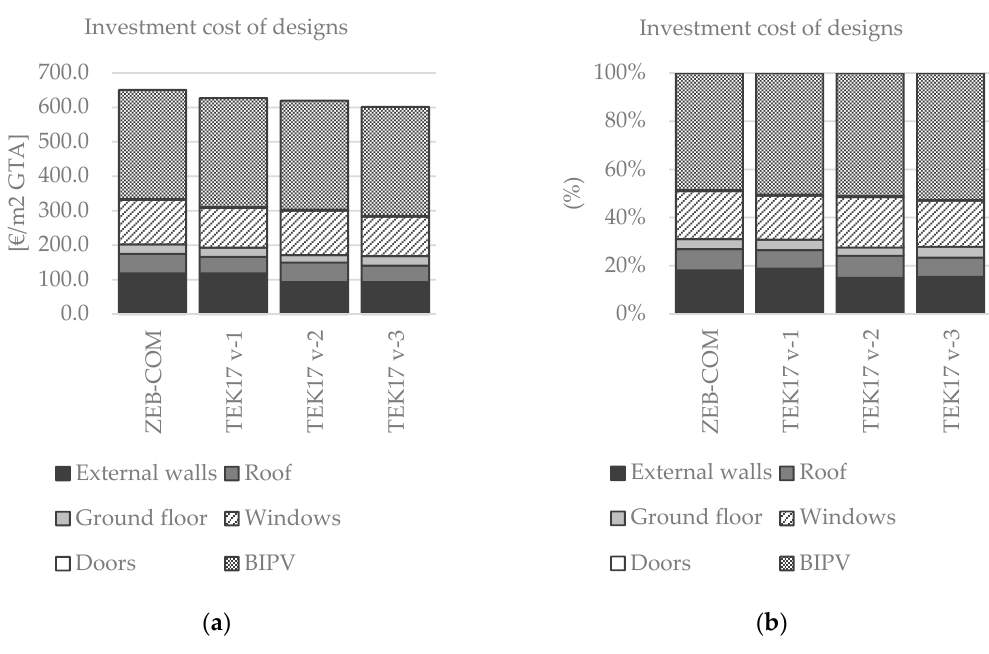
Figure 1. Figure 1. Net energy need and delivered energy of the four designs simulated with the Trondheim climate.